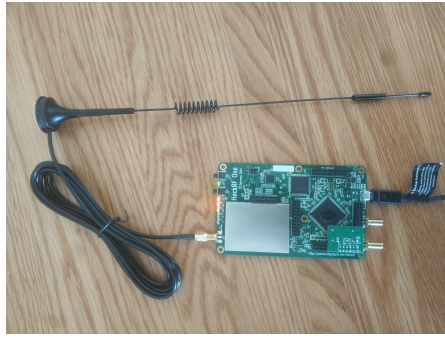
Figure 12. A simple GPS spoofer.